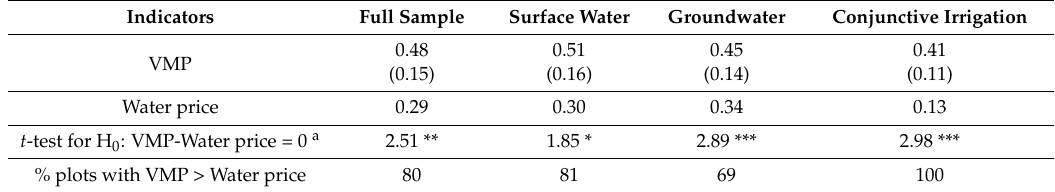
Table 7. Average value of marginal product and price of water (yuan/m 3 ) for wheat in ZB. Indicators Full